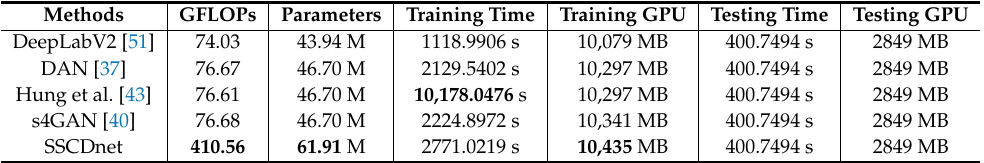
Table 8. Computational complexity analysis of different semi-supervised methods and the baseline method (DeepLabV2